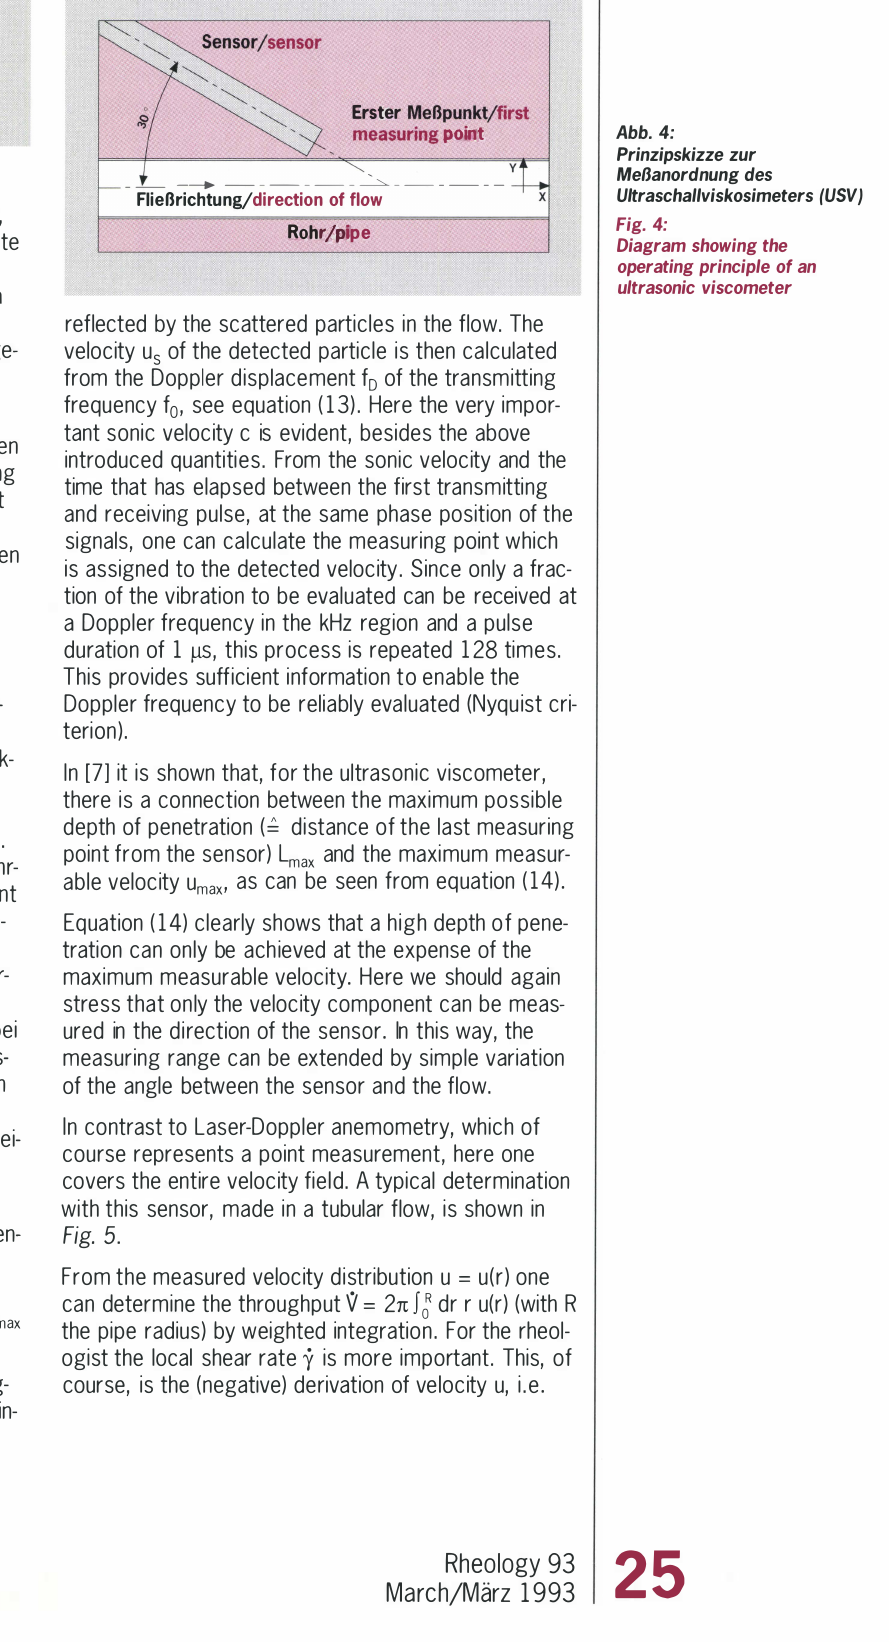
Fig. 3: Flow curve of an aqueous p,oly�cryl�mide (PAAm) solution (Stockhausen, Praesto/2540). Determination of zero viscosityl)0 (*)and comparison of results from the GRLDA determination (e) with determinations using a commercia/ rotational viscometer (Haake RV20-CV100 {0)